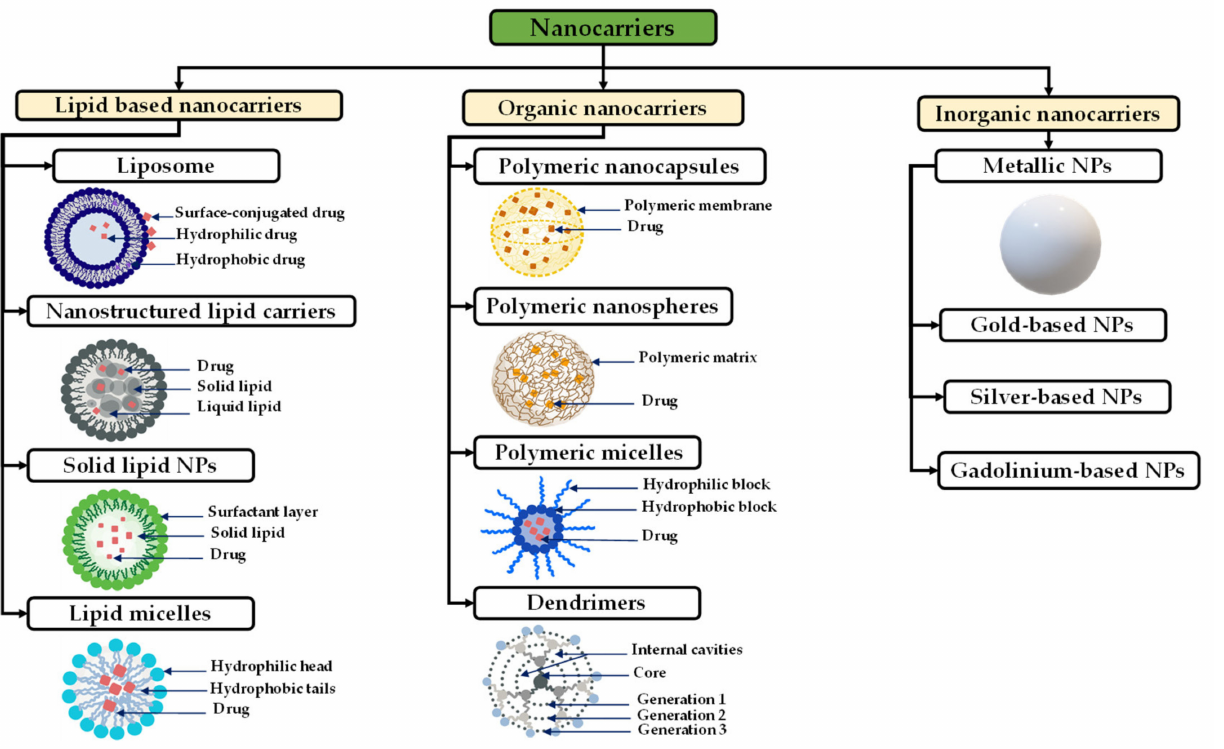
Figure 5. Schematic representation of different types of nanocarriers and their structures used in GBM